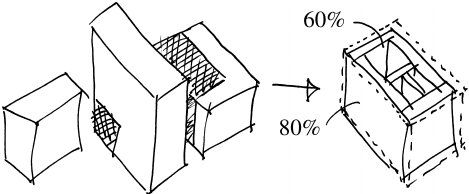
Figure 2. Use case 1: Irradiation potential analysis on the city model (left) followed by thermal energy simulation on the building model (right)